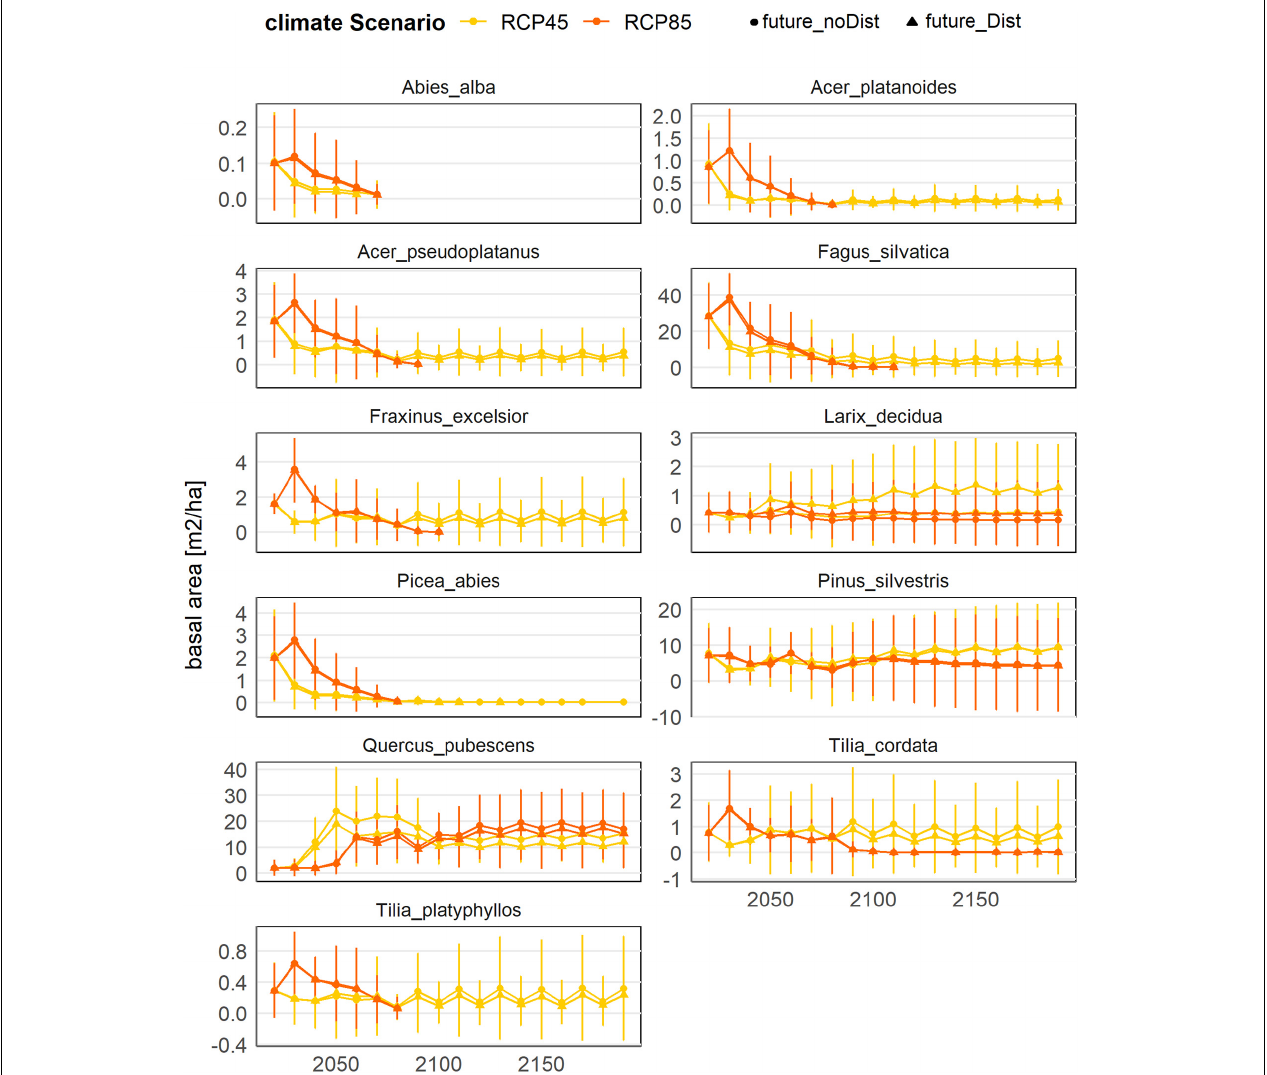
FIGURE 7 | Simulated evolution of the basal area of the main species in Martigny under climate scenario RCP4.5 (yellow) and RCP8.5 (orange) and for low (points) and high (triangle) background disturbance (Dist).